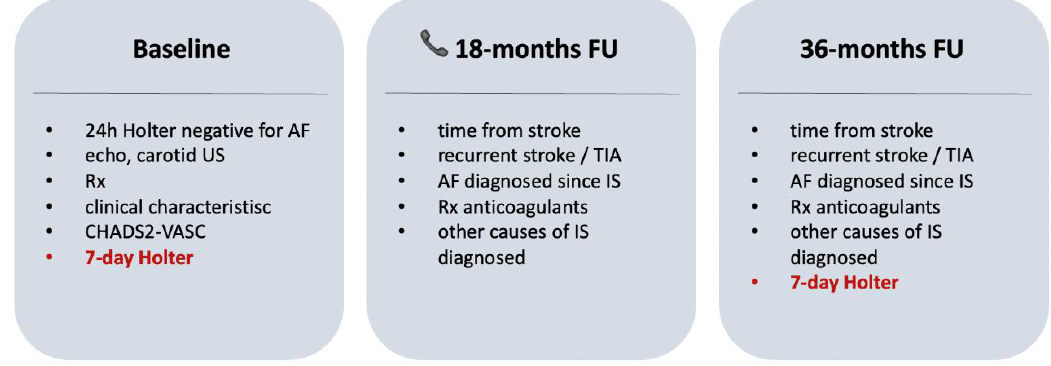
Figure 1. Study design plot.